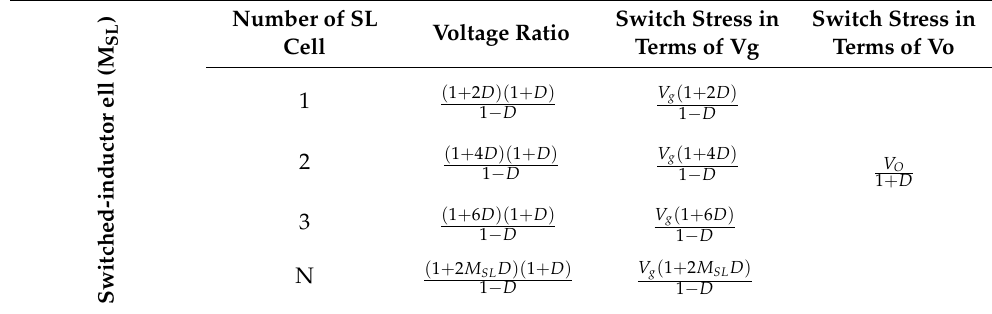
Table 2. Correlation for 1, 2 … M SLn switched-inductor cell (M SL ) with single Switched-capacitor cell.